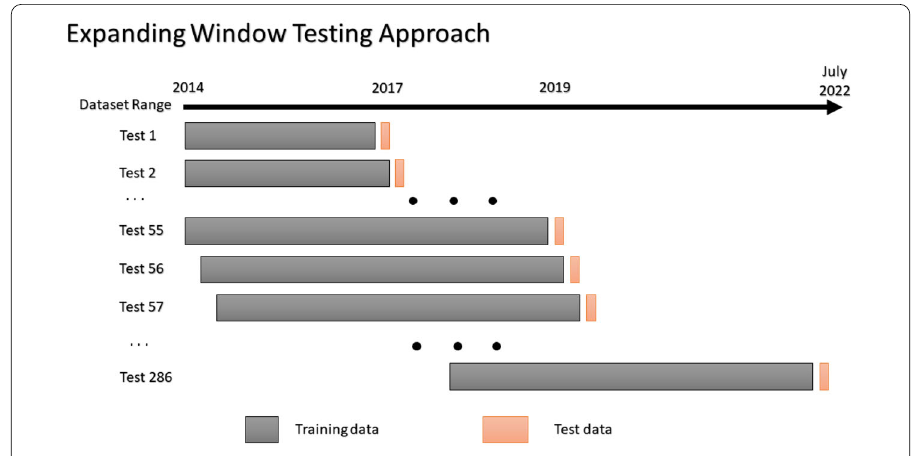
Figure 5 The expanding window testing approach used in this study. Each testing window represents a one-week period. In total 286 training and testing cycles were performed for each model covering the periods between 2017 and July